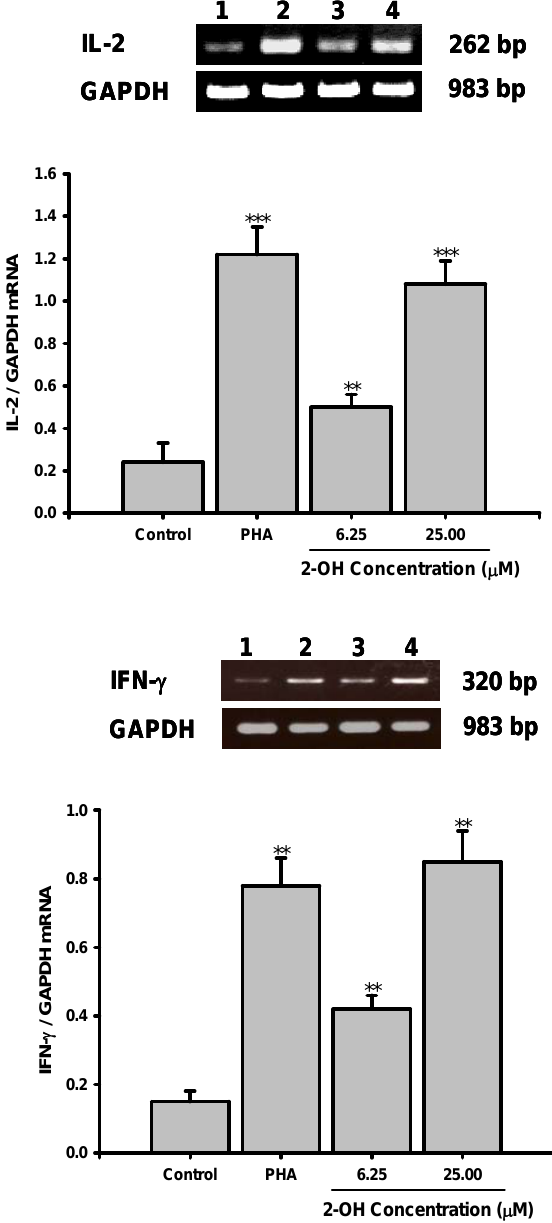
Figure 4. Effects of 2-OH on: (A) IL-2 and (B) IFN- γ mRNA expression in PBMC, as detected with RT-PCR. PBMC (5 x 10 6 ) were cultured with PHA (5 µg/mL) or 6.25 and 25 μ M 2-OH for 18 hr. The total cellular RNA was isolated from PBMC and aliquots of RNA (1 μ g) were reverse-transcribed for synthesis of cDNA. PCR was done as described in Materials and Methods. Following the reaction, the amplified product was taken out of the tubes and run on 2% agarose gel. Lane 1: Control (0.1% DMSO), Lane 2: PHA, Lane 3: 6.25 μ M 2-OH , Lane 4: 12.5 μ M 2-OH . Each band was quantitated using laser scanning densitometer SLR-2D/1D (Biomed Instruments Inc., Fullerton, CA, USA). The ratio of IL- 2 or IFN- γ mRNA to GAPDH mRNA was calculated. Each bar is the mean ± S.D. of three independent experiments with PBMC from different individuals. **P < 0.01, ***P < 0.001, as compared with control